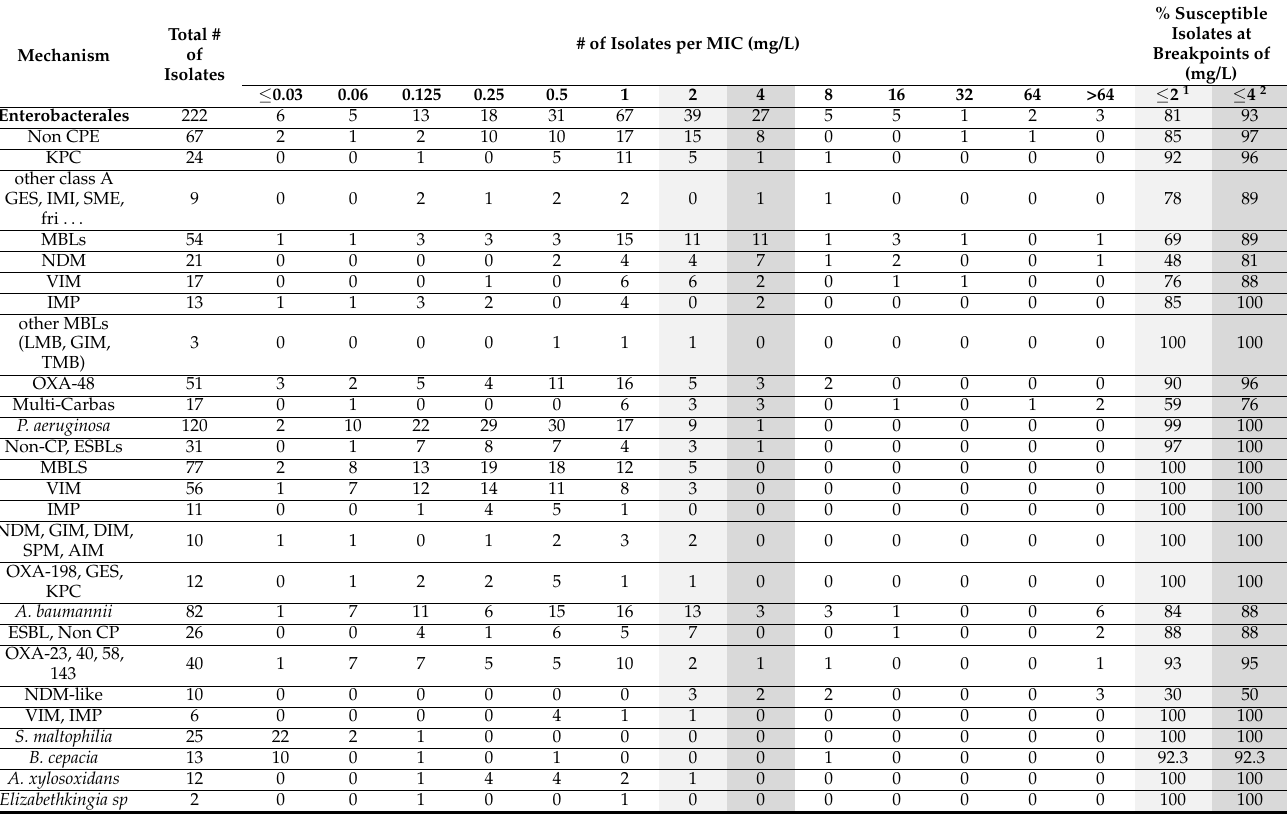
Table 2. MIC distributions of cefiderocol by resistance mechanism and species